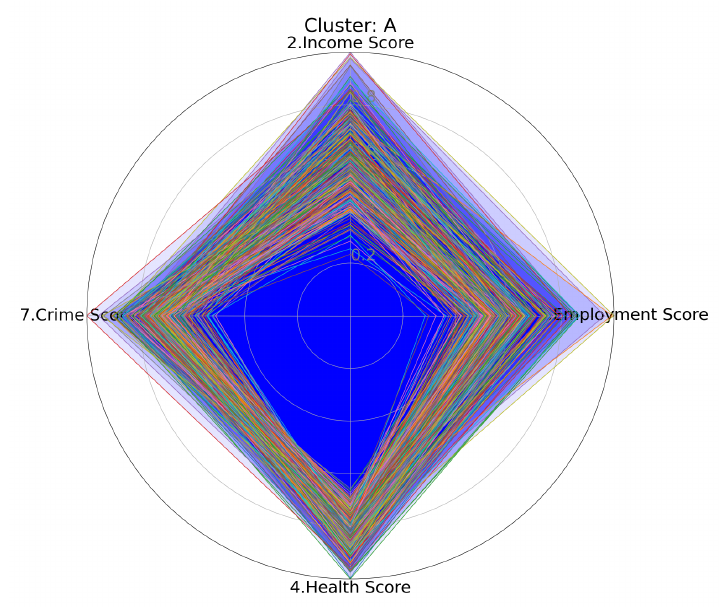
Figure 9. Stacked radar graphics showing cluster A of normalized values for case 3.